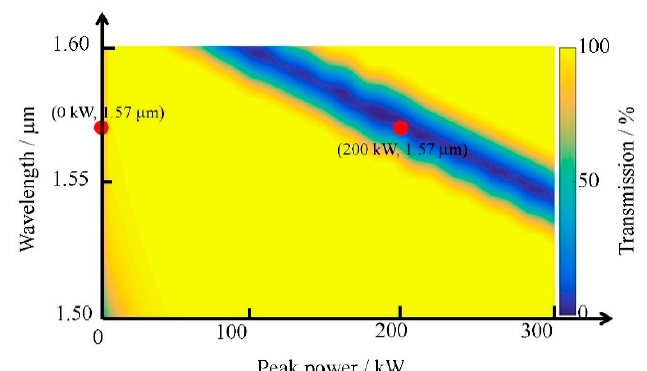
Figure 5. Calculated transmission spectrum of the all-solid double-clad tellurite PBGF with the control pulse power increasing from 0 to 300 kW.